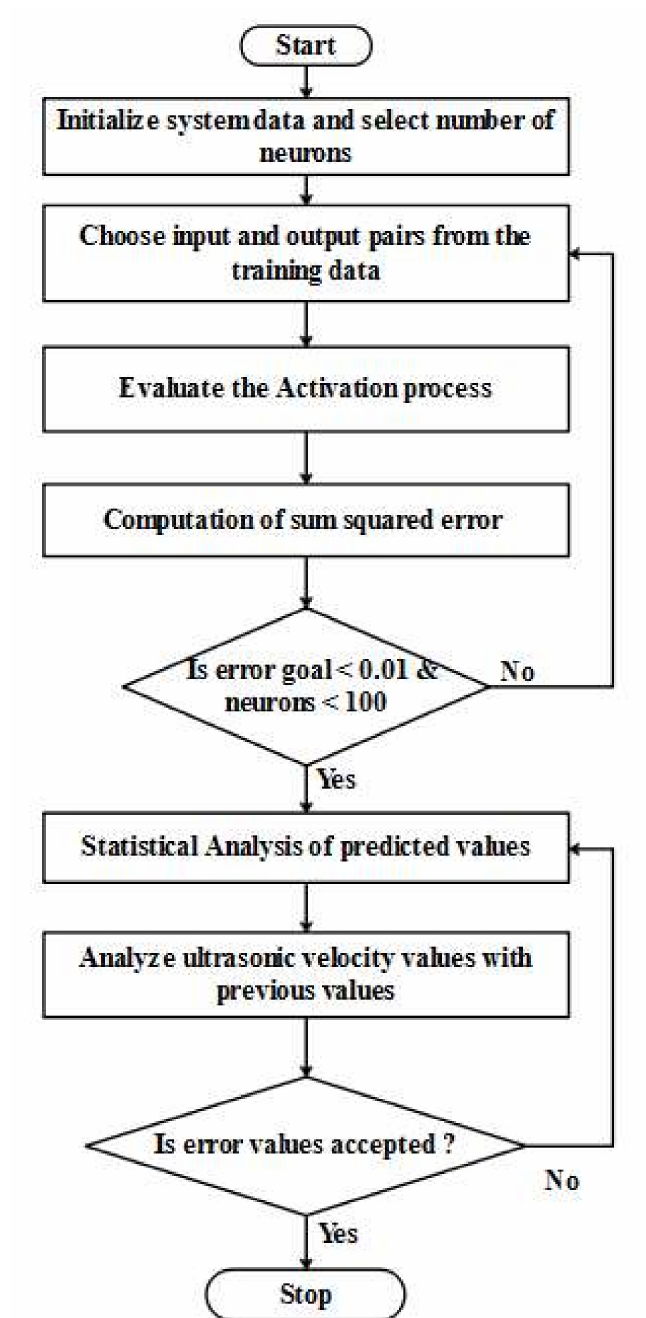
Figure 6. Flowchart for the proposed